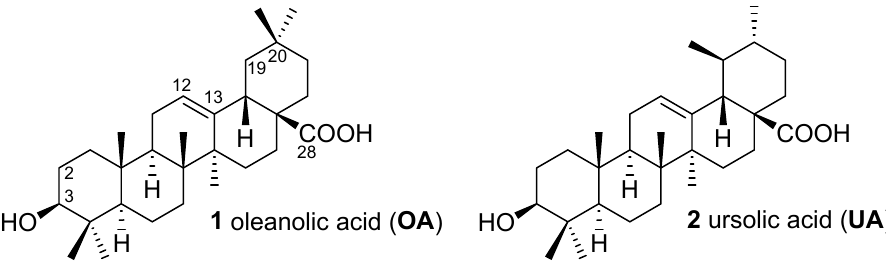
Figure 1. Structures of oleanolic ( 1 ) and ursolic ( 2 ) acids.